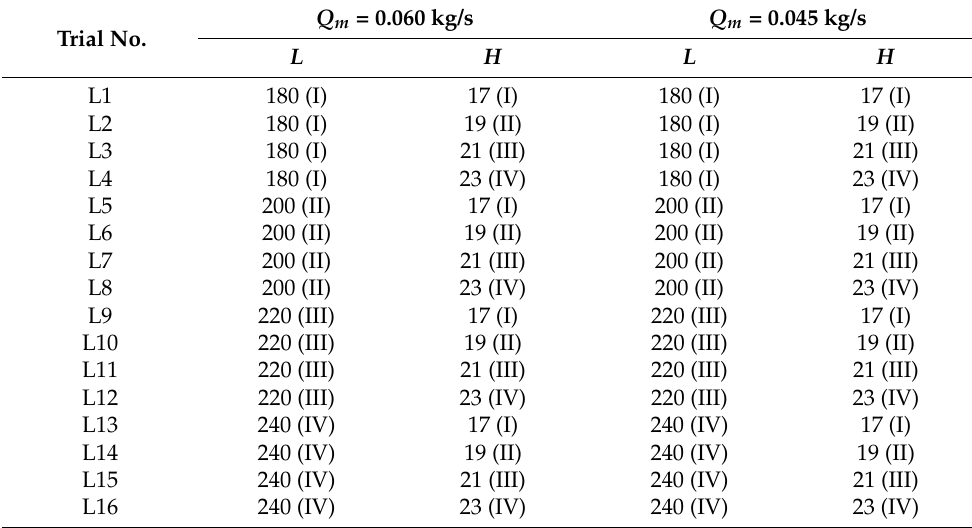
Table 2. L16 orthogonal array